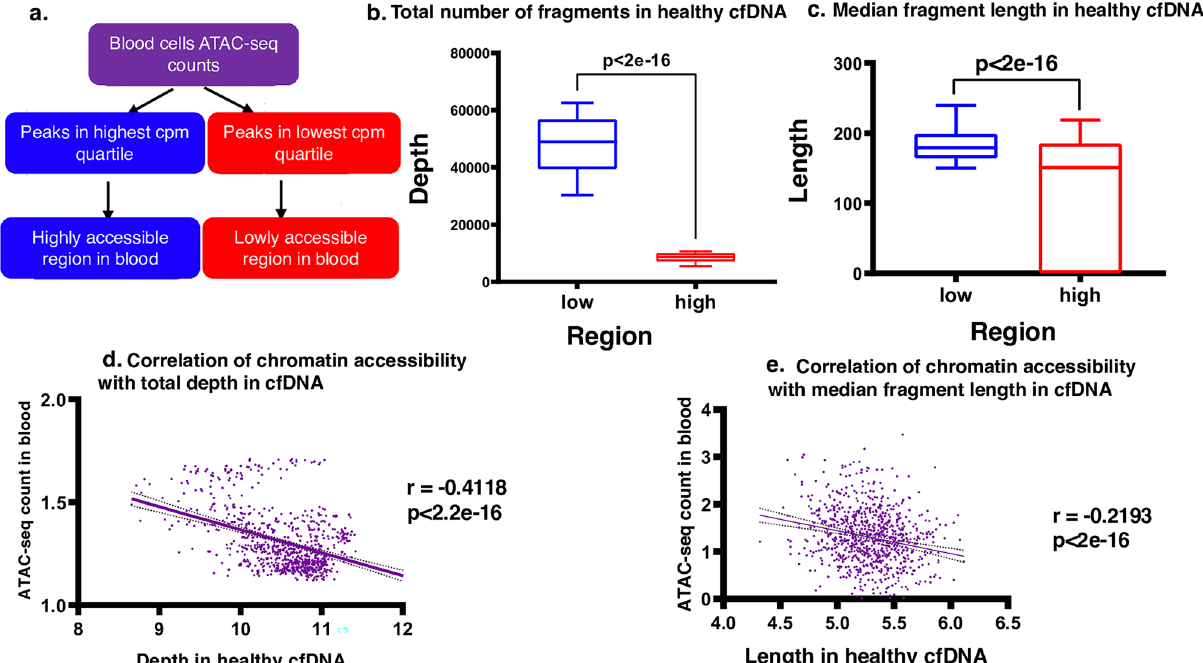
Figure 1. Chromatin accessibility differences are reflected in cfDNA fragmentation patterns ( a ). Workflow diagram showing how blood ATAC-seq data was used to define genomic regions with low and high accessibility. ( b ) Total number of fragments per region is shown in deep (~ ×104) WGS sample from cfDNA of a healthy individual (IH01 from 27 Mean in the low group = 47,891; Mean in the high group = 8381. ( c ) Median fragment length per region is shown in deep (~ ×104) WGS sample from cfDNA of a healthy individual (IH01 from 27 . Whiskers show 10–90 percentile (Mean in the low group = 192.4; Mean in the high group = 111.3). ( d , e ) Pearson correlation analysis of accessibility with coverage depth ( d ) and with fragment length ( e ) in cfDNA sample of a healthy individual (IH01 sample from 27 ) in blood cells